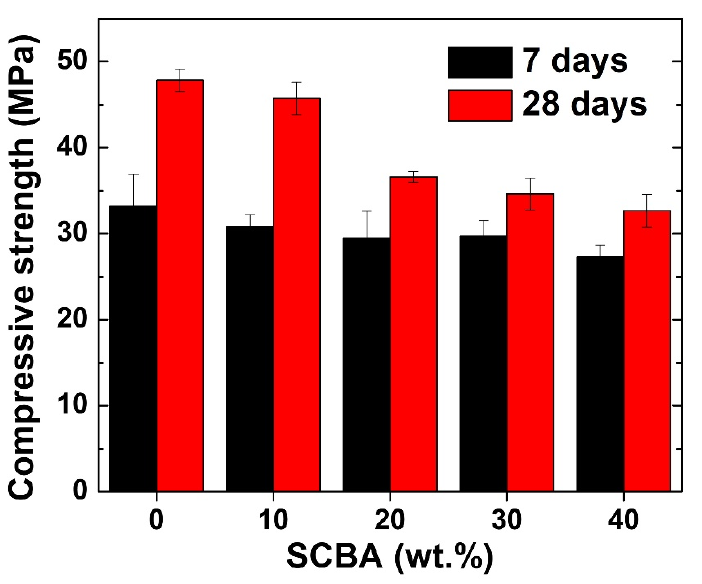
Figure 5. Compressive strength of geopolymer paste and geopolymer/SCBA composite pastes.